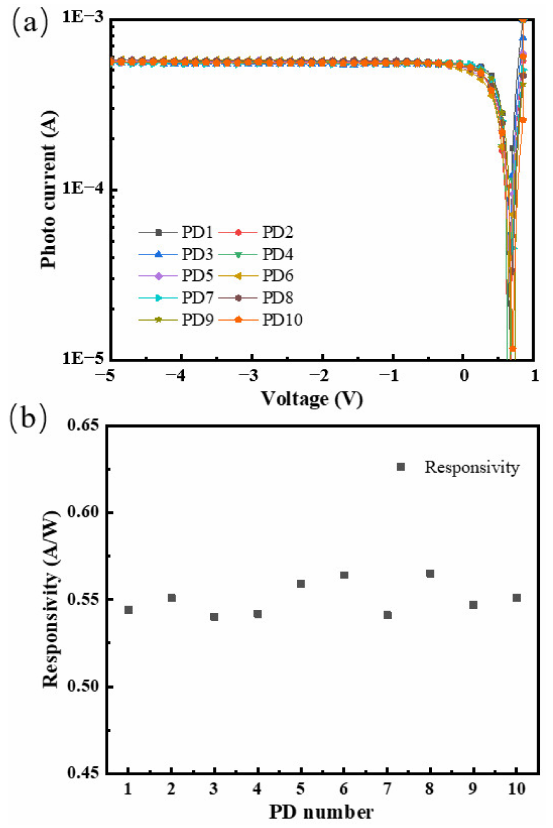
Figure 5. ( a ) The photocurrent measurement result of the photodetector array as a function of voltage bias without an anti-reflection (AR) coating, ( b ) The responsivity result of the photodetector array without an anti-reflection (AR)